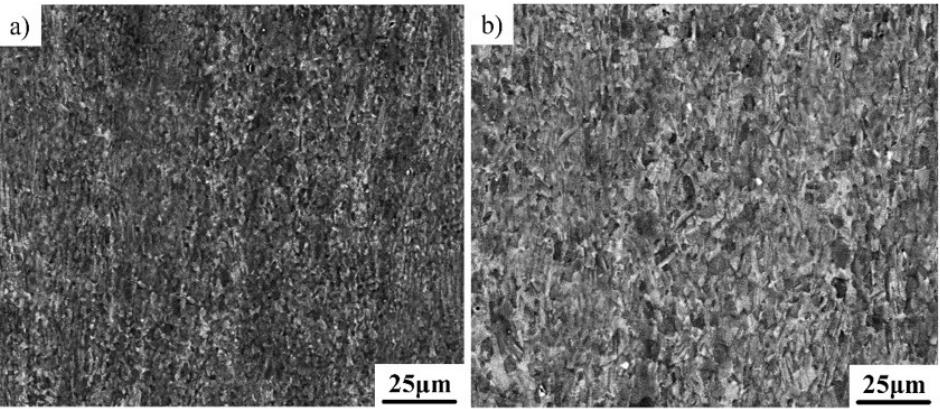
Figure 5. The microstructure of the Ti–43Al–3Mn–2Nb–0.1Y alloy compressed at ( a ) 1200 °C/0.01 s −1 , and ( b ) 1250 °C/0.01 s −1 .